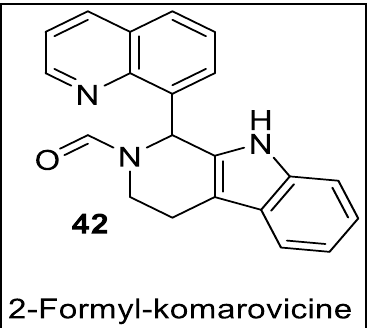
Figure 46. Chemical structure of 2-formyl-komarovicine ( 42 ) .